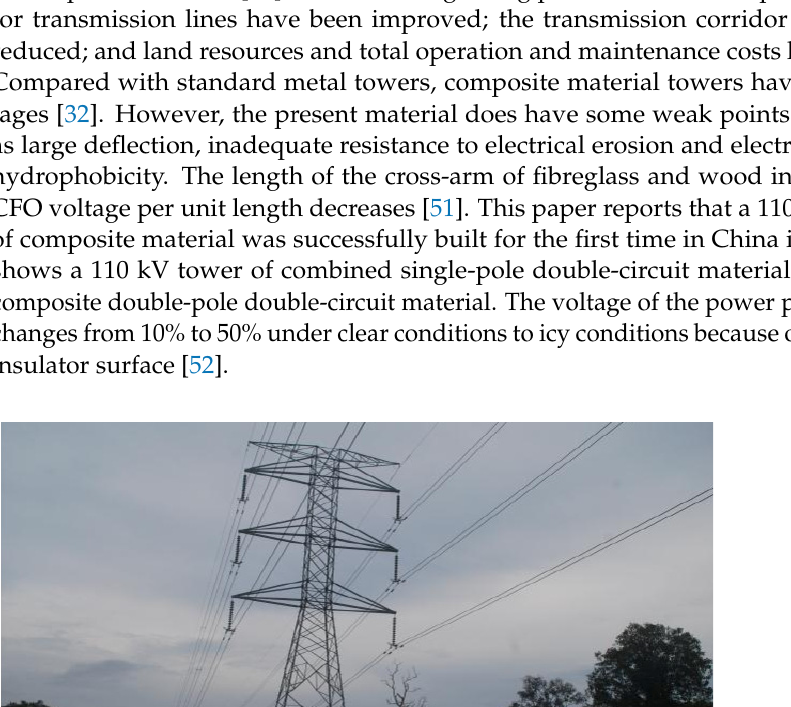
( b ) Figure 9. ( a ) 110 kV tower of combined composite single ‐ pole double ‐ circuit material and ( b ) 110 kV tower of complete composite double ‐ pole double ‐ circuit material [31]. 